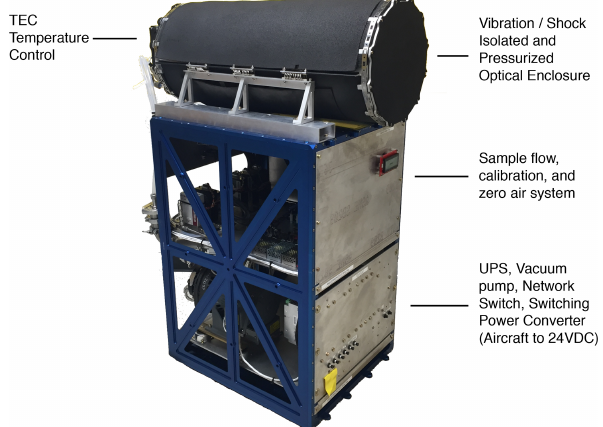
Figure 1. Instrument layout and components.